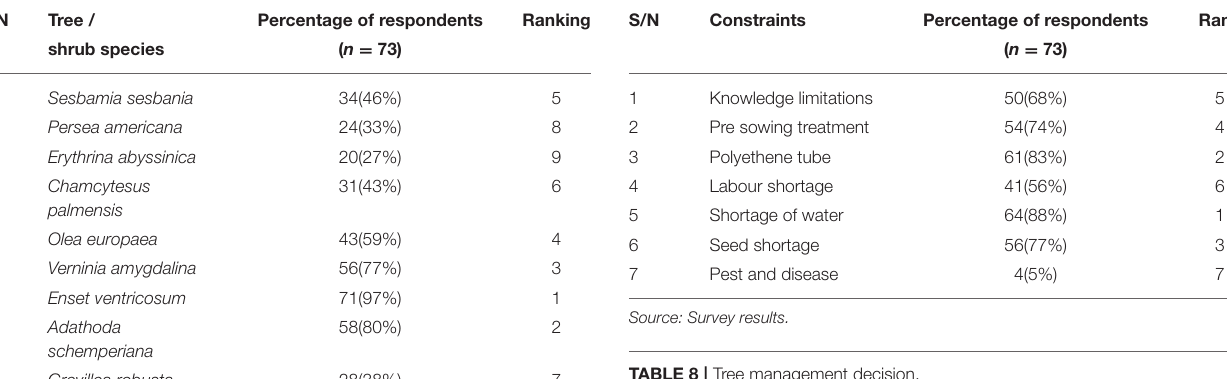
TABLE 7 | Constraints in Agro-forestry nurseries.